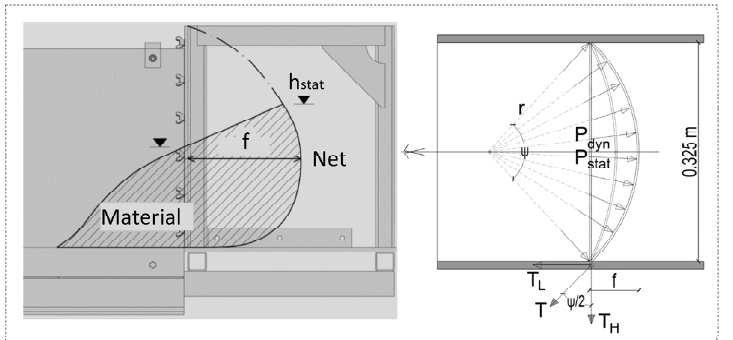
Figure 10. Deposition of the material in the flexible barrier: tangential rope force ( 𝑇 ), horizontal component ( 𝑇 𝐻 ) and normal impact forces ( 𝑇 L ) of the rope.